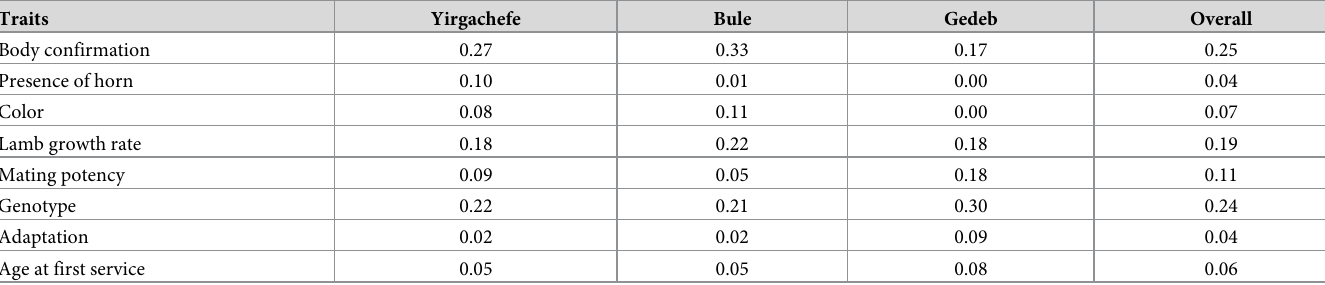
Table 9. Indices of various criteria to select best rams in sheep